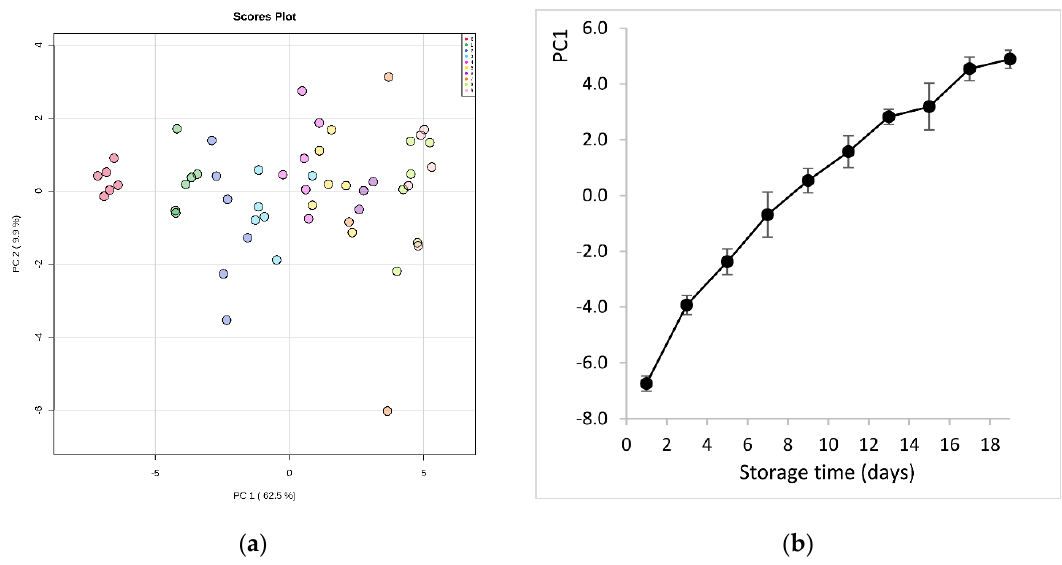
Figure 2. ( a ) Principal component analysis (PCA) score plot derived from the hydrophilic metabolites of sea bream during storage on ice. The legend indicates the sampling sequence (0-1-2-3-4-5-6-7-8-9) that corresponds to storage day (1-3-5-7-9-11-13-15-17-19), respectively; ( b ) evolution of sea bream spoilage as described by PC1 scores values vs. storage time on ice.